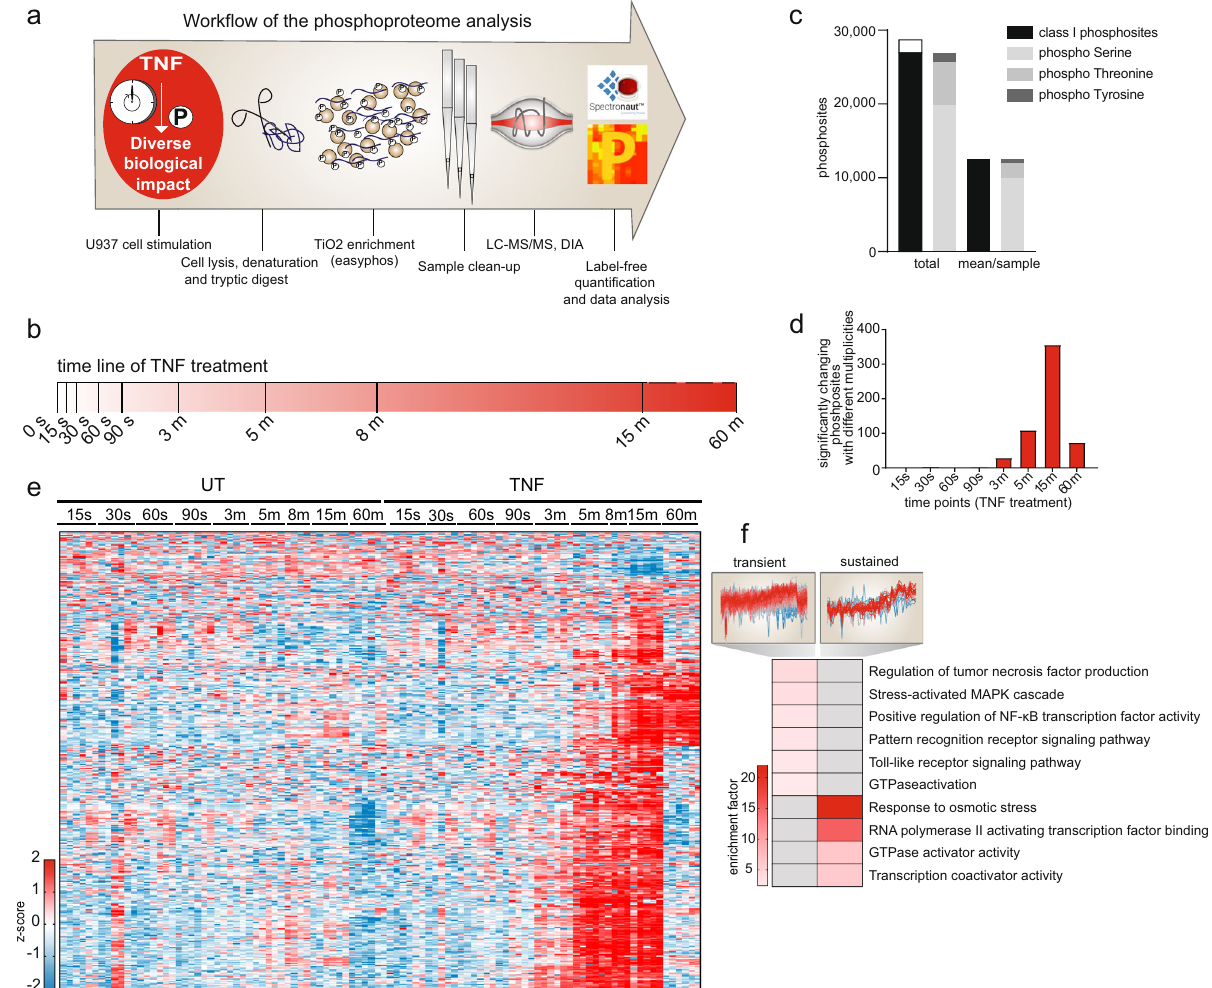
Fig. 1 Temporal dissection of TNF-regulated phosphorylation events. a Work fl ow of the phosphoproteome analysis. b Schematic overview of the time points used for TNF treatment (100 ng/ml). c Bar graph demonstrating the number of detected phosphosites in U937 cells. Class I sites (in black) are phosphosites with a localization probability of > 75%. d Histogram depicting the numbers of signi fi cantly changing phosphosites along eight different time points compared with the respective untreated control (FDR < 0.05; see Methods for an 8-min time point). e Heatmap of signi fi cantly changing phosphosites along the time course compared with their respective untreated controls (Student ’ s t -test; FDR < 0.05). Z-scores of various time points and the replicates ( n = 4 biologically independent experiments) in red for intensities higher than the mean and in blue for intensities lower than the mean of the respective phosphosites across all samples. f Fisher ’ s exact test of transient phosphosites induced upon TNF, which are downregulated after 15 min and sustained phosphosites, which are still upregulated at 60 min of treatment (two-sided, p < 0.002). The red scale resembles enrichment, while gray represents missing values/no enrichment. The pro fi les are color-coded according to their distance from the respective cluster center (red is close to the center, blue is further away from the center). Source data are provided as source fi